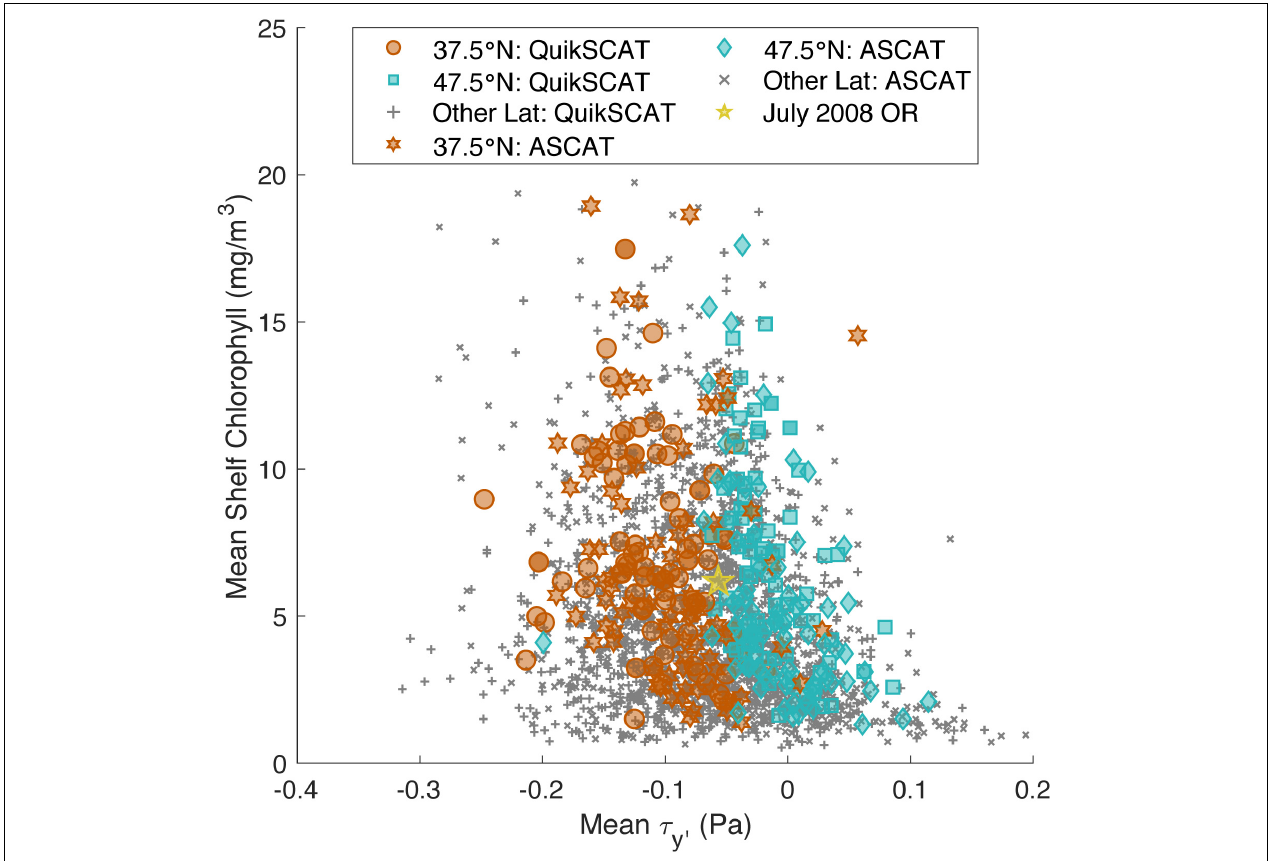
FIGURE 3 | Mean 8-day composite shelf chlorophyll concentration plotted against its corresponding wind stress for each latitude from 35.5 to 49.5 ◦ N, with a distinction made between wind stresses derived from QuikSCAT measurements (January 2000–October 2009) and ASCAT measurements (November 2009–December 2019). Data from 37.5 ◦ N (between 37 and 38 ◦ N) is shown in orange circles (QuikSCAT) and orange hexagons (ASCAT), and data from 47.5 ◦ N (between 47 and 48 ◦ N) is shown in blue squares (QuikSCAT) and blue diamonds (ASCAT). The failed bloom in OR (44.5 ◦ N) in July 2008 (Evans et al., 2015) is depicted by the yellow star. All other latitudes are shown in gray crosses (QuikSCAT) and in gray Xs (ASCAT